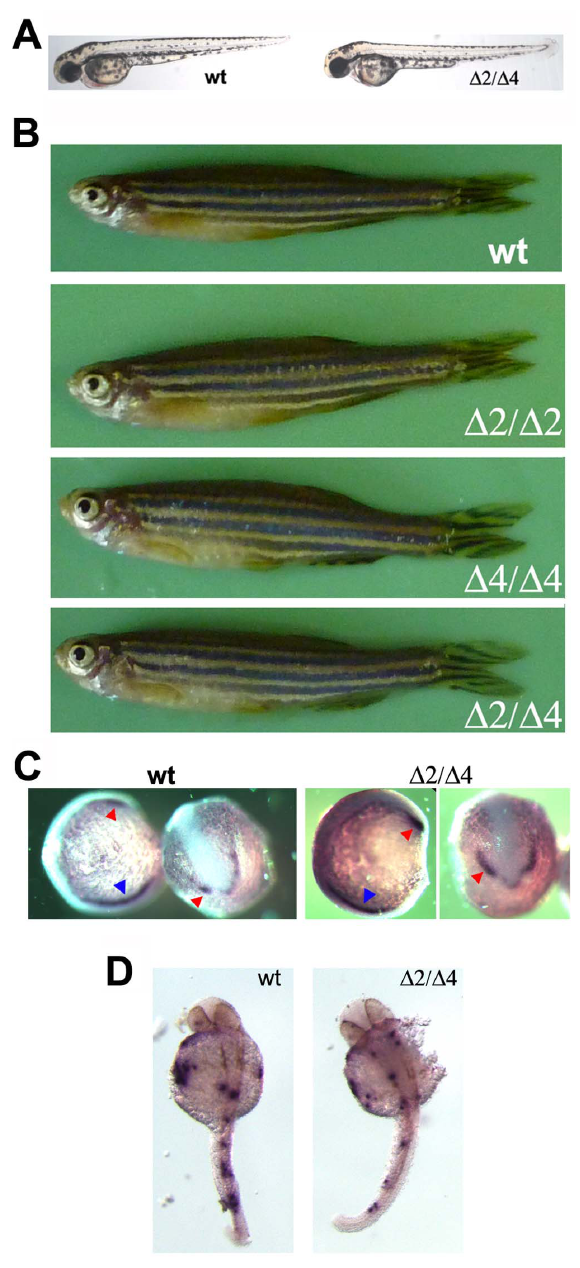
Figure 2. Morphological phenotype of live pak4 D 2/ D 4 mutants. (A) wild type and F 3 mutant fish at 2 dpf. (B) wild type and F 3 mutant fish at 6 months. Fish were first photographed for documentation followed by fin biopsy genotyping for confirmation. (C) Whole mount in situ hybridization of wild type and mutant embryos at 7-somite for scl . Lateral (left) and dorsal (right) views are shown. Red and blue arrowheads indicate anterior and posterior blood domains, respectively. (D) Whole mount in situ hybridization of wild type and mutant F 3 embryos at 30 hpf for mpo . wt, wild type EK. In panels A, C and D, D 2/ D 4 refers to the mixed population of homozygous mutant and trans- heterozygous mutant embryos. Panel B shows individuals of each defined genotype, all of which were normal and